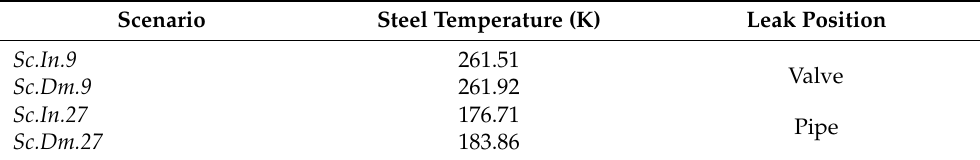
Figure 22. Steel temperature of leakages from valve ( a ) and pipe ( b ). Table 11. Minimum steel temperatures of leakages from the valve and pipe with 50 mm leak diam- eter.